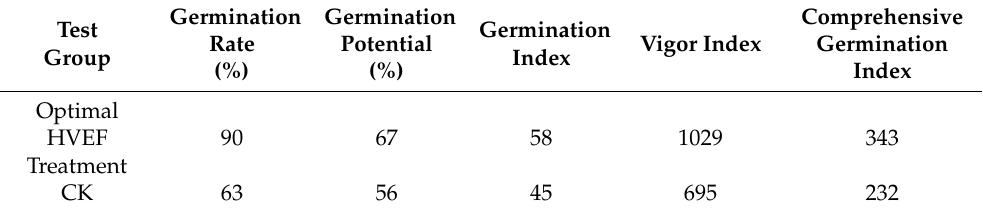
Table 4. Verification of Test